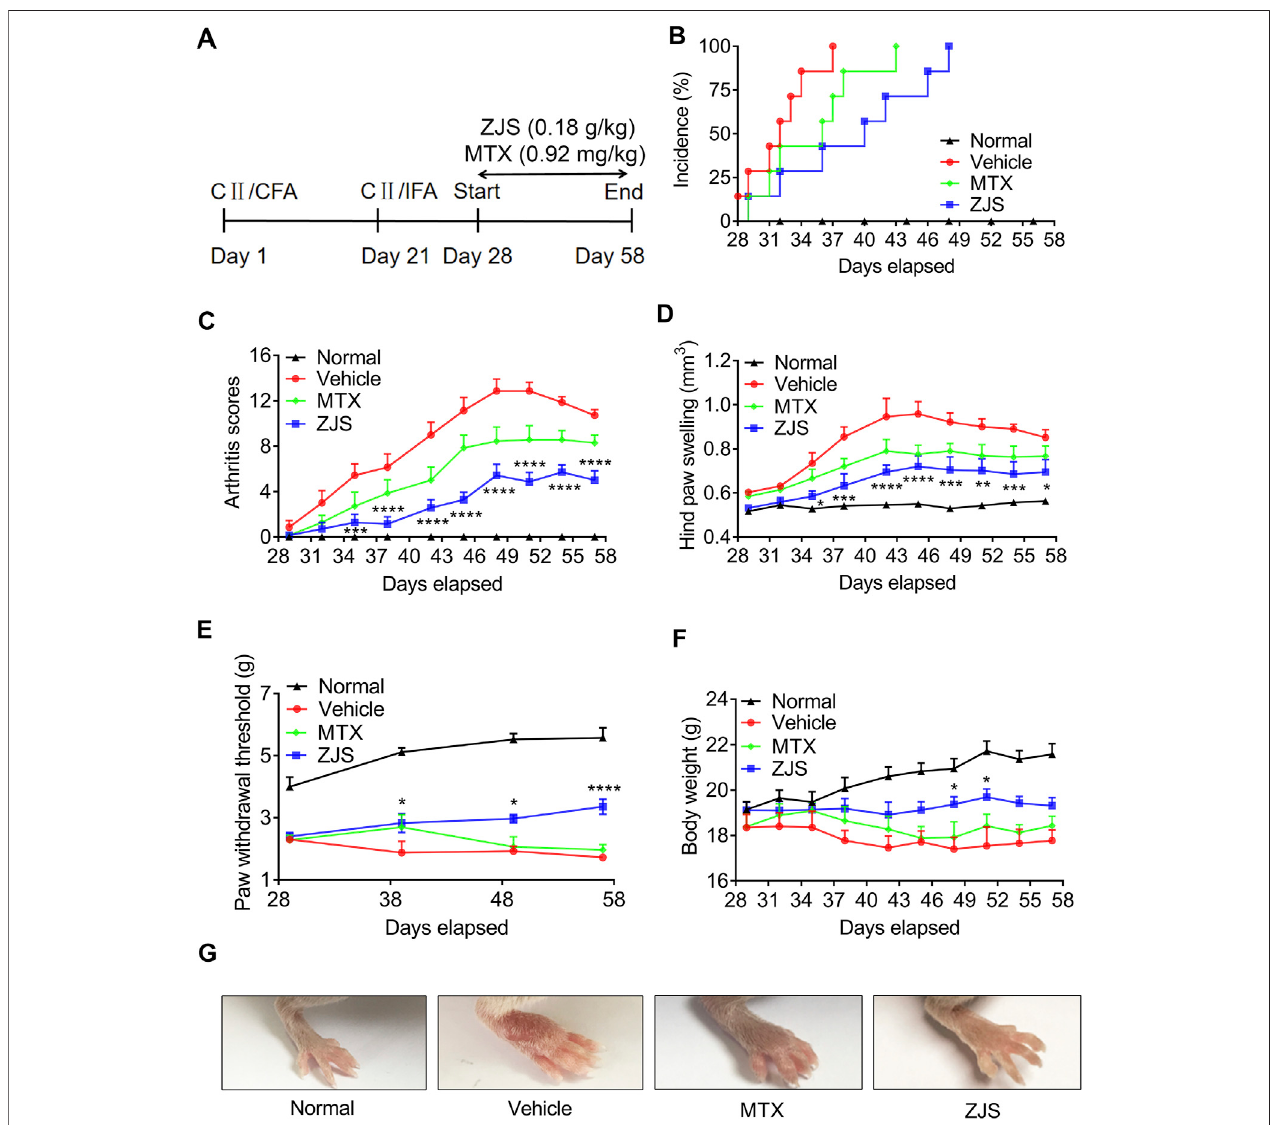
FIGURE 1 | ZJS delayed the onset of arthritis and ameliorated arthritis severity in CIA mice. (A) Experimental scheme of the analysis of CIA mice. (B) Incidence of arthritis in each group was determined ( n (cid:1) 7). (C) Changes in the arthritis score were assessed in each group ( n (cid:1) 7). (D) Changes in the hind paw swelling were measured in each group ( n (cid:1) 7). (E) Changes in the paw withdrawal threshold were detected in each group using von Frey fi laments ( n (cid:1) 7). (F) Changes in body weight weremeasuredineachgroup( n (cid:1) 7). (G) Representativeimagesoftheanklejointsofthemicetakenonday51fromtheexperimentintheindicatedgroups.Values are presented as the mean ± SEM. * p < 0.05, ** p < 0.01, *** p < 0.005, **** p < 0.001, compared with the vehicle group (Two-way ANOVA